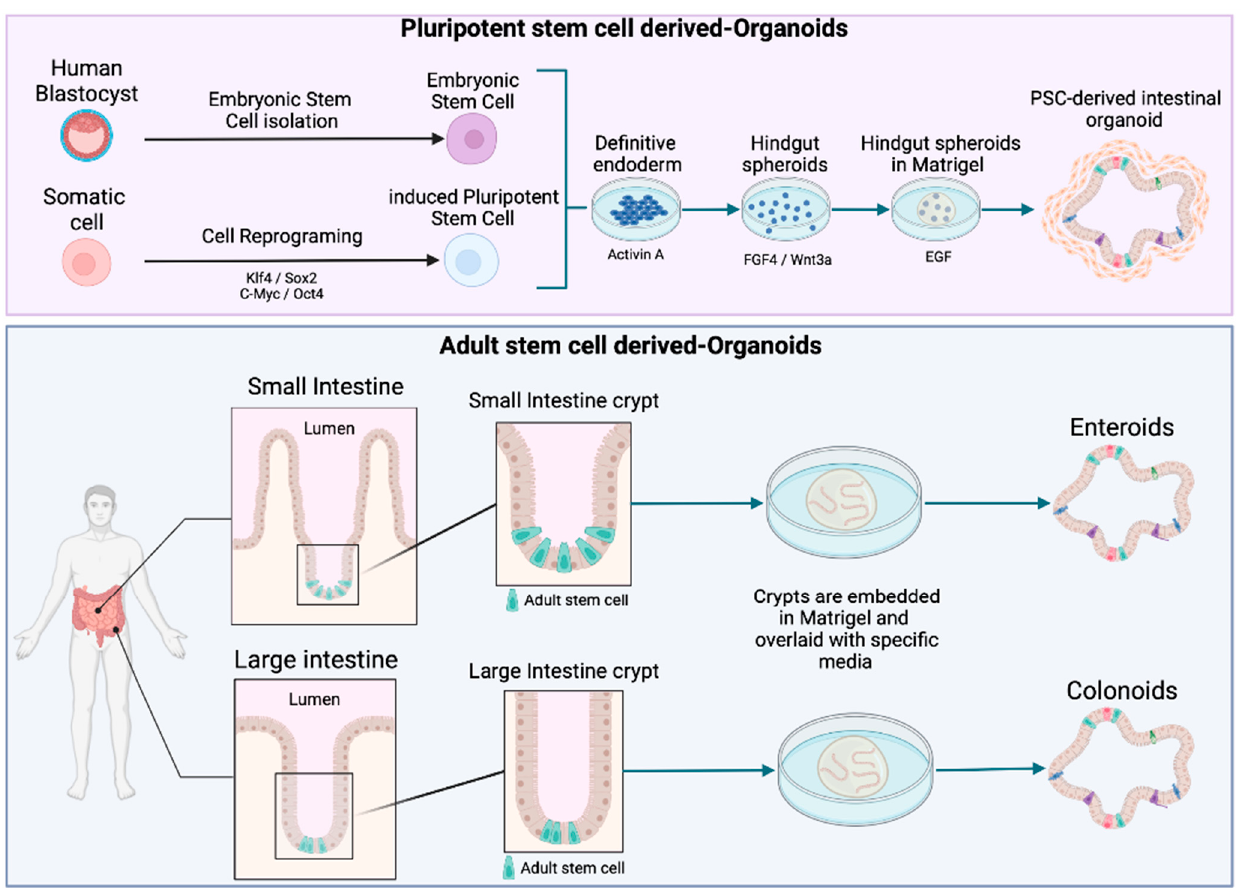
Figure 2. Schematic diagram of intestinal organoid, enteroid, and colonoid generation. Organoids can be derived from pluripotent stem cells (PSCs), including either induced pluripotent stem cells (iPSC) or embryonic stem cells (ESC). Enteroids and colonoids can be grown from the adult stem cells (AdSC) isolated from intestinal crypts.